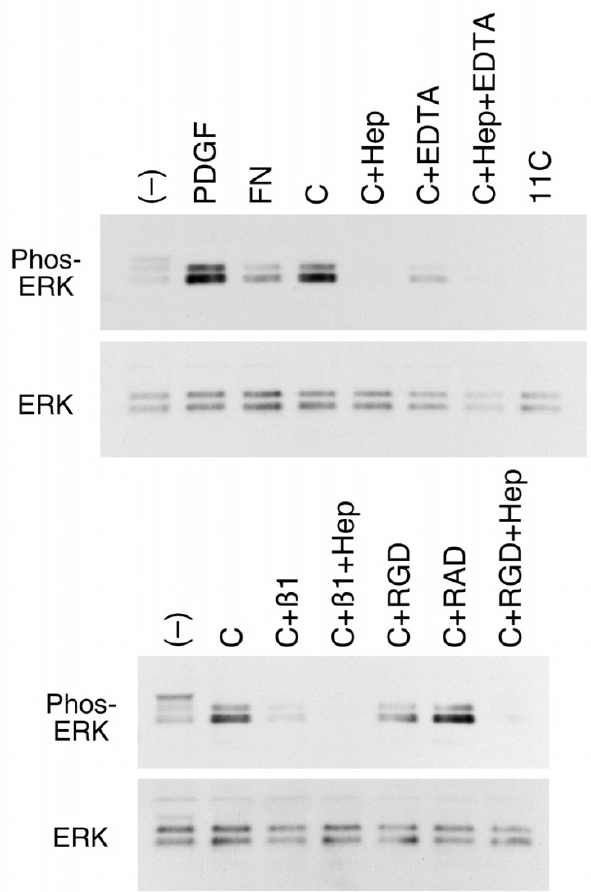
Figure 6 Inhibition of III1-C mediated ERK activation by vari- ous integrin inhibitors. RASMCs were collected in DMEM+0.5% BSA and were then either left in suspension in the absence (-) or presence of PDGF (PDGF), or plated onto dishes precoated with either fibronectin (FN), III1-C (C and C+... lanes), or III 11-C (11C), as described in the legend to Fig. 5. Some samples of cells plated onto III1-C also contained either 100 µ g/ml heparin (C+Hep), 10 mM EDTA (C+EDTA), 50 µ g/ml anti- β 1 blocking mAb Ha2/5 (pi), 0.5 mg/ml GRGDSP peptide (RGD), 0.5 mg/ml GRADSP peptide (RAD), or combinations of heparin plus integrin inhibitors, as indicated. After 30 min at 37 ° C cells were lysed in SDS- PAGE sample buffer and samples were analyzed by immunob- lotting with anti-phospho-p44/42 MAPK antibodies (Phos- ERK panels). Blots were then stripped and reprobed with anti-ERK antibodies (ERK panels) to analyze protein loading. The experiment was done 3 times with similar results each